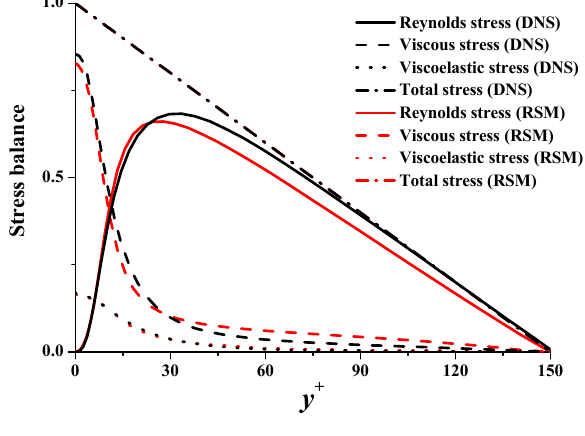
Figure 4. Stress balance.